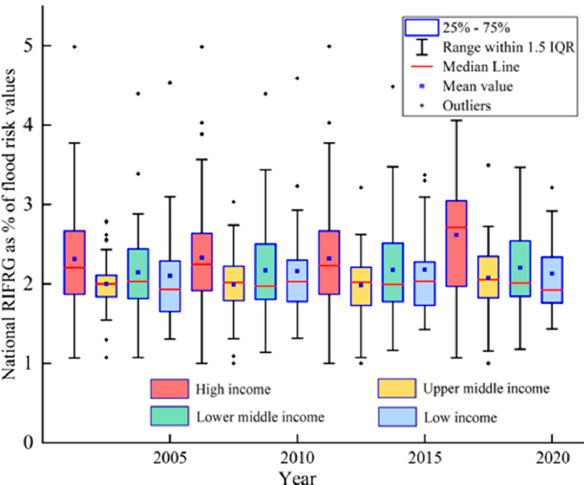
Figure 9. National RIFRG changes at different income levels for 2005–2020.